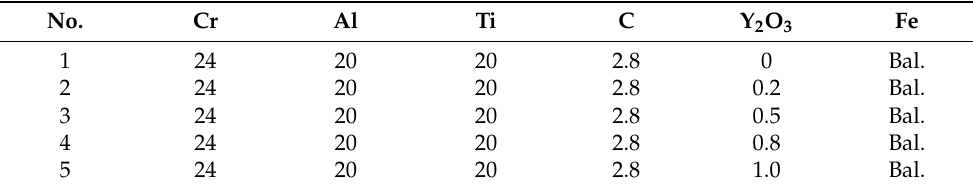
Table 1. Chemical composition of the mixed powders